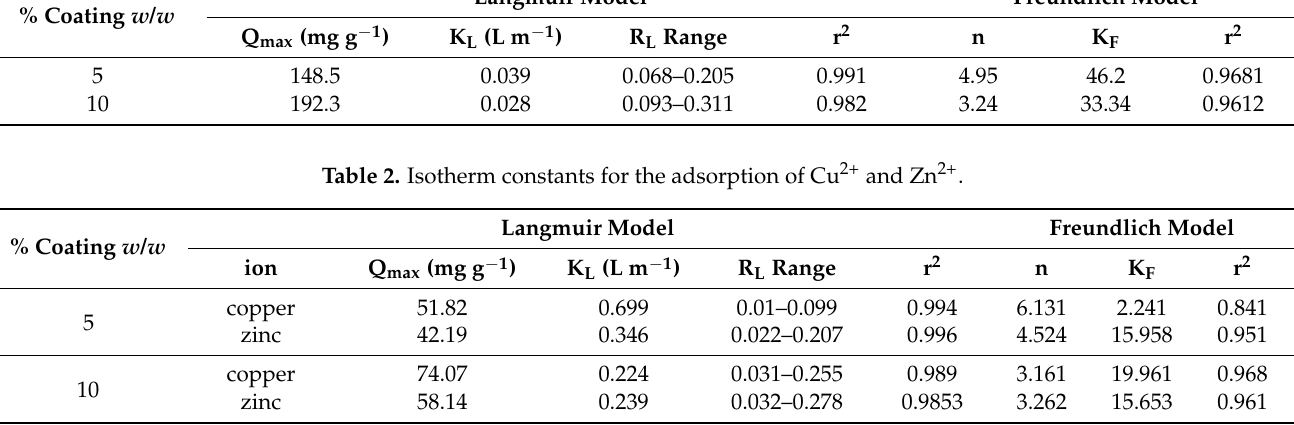
Table 1. Isotherm constants for the adsorption of Cu 2+ . Langmuir Model